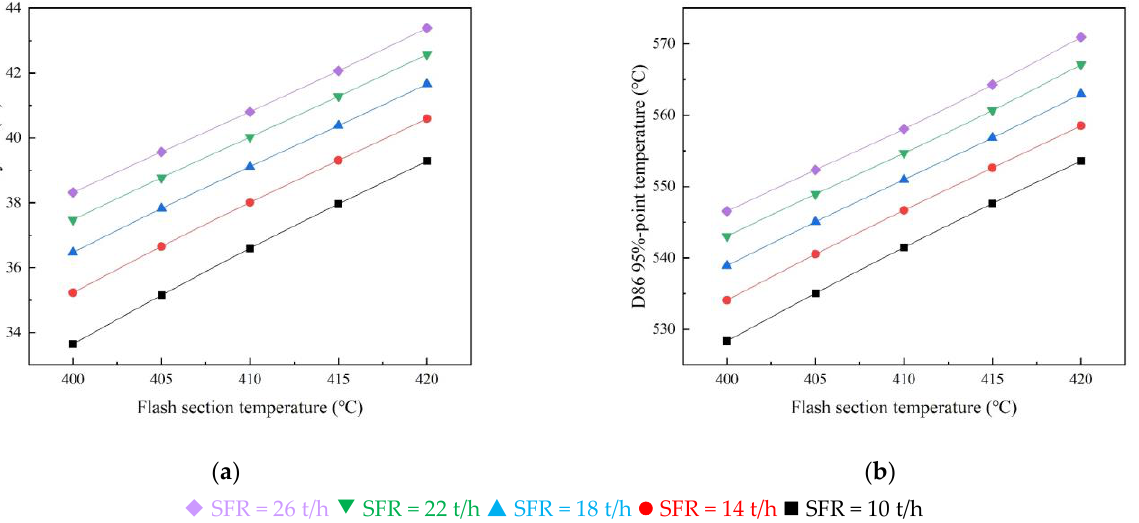
Figure 12. The effect of FST at different SFR on the effect of deep-cut vacuum distillation. ( a ) HVGO yield change; ( b ) HVGO D86 95%-point temperature change.